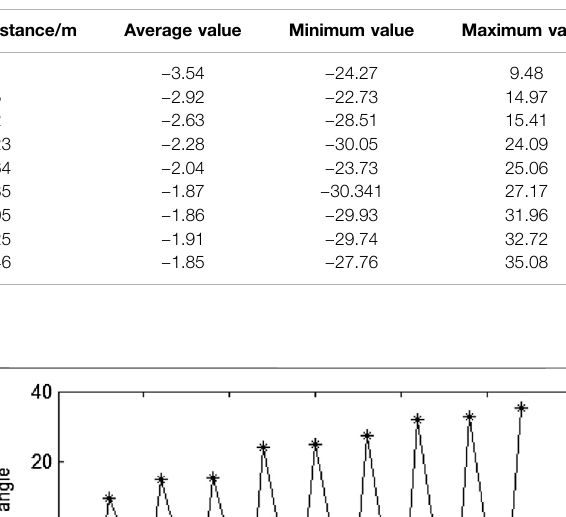
TABLE 2 | Yaw error data at each distance of the radar.